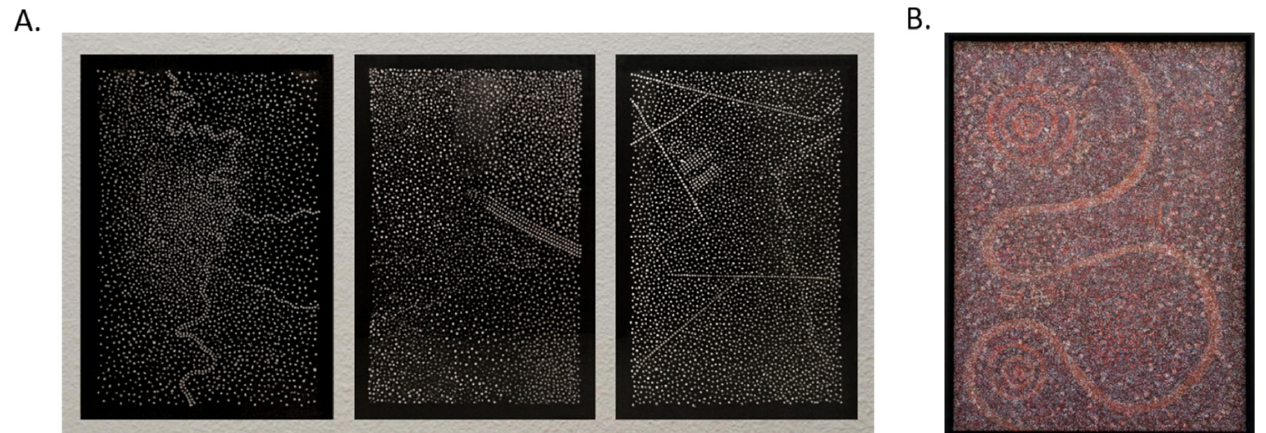
5 of 8 Figure 2. Pilot fungal dot painting on black acrylic glass. A total of 10 5 conidia/mL were suspended in molten YAG agar at 50–55 °C, point inoculated on black acrylic glass (50 × 70 cm) at 50 µL agar volume to generate the prominent dots or at 30 µL agar volume to generate the weaker background dots. The glass was incubated for 48 h at 37 °C in a humid box. A close-up photograph of the dots (right panel) reveals their heterogeneous mycelial density and texture. Finally, three fungal dot painting artworks were prepared on 80 × 120 cm black acrylic glass, using the methods developed above (Figure 3A). An example of an aborigi- nal art dot painting, which inspired our work, is shown alongside (Figure 3B). The paint- ing is by an aboriginal artist Barbara Weir and is entitled My Mother’s Country [20]. Abo- riginal paintings serve as a medium to convey one’s heritage and ancestral mythology, usually within the geographic context in which that heritage played out. The present se- ries of three paintings similarly relates to the artist’s heritage, depicting the cities and landscapes in which the artist’s family history unfolded. The use of mycelial culture in this context is essential and integral to the artistic concept. It ties in conceptually to the idea of a landscape or terrain being alive and serving as a cultural catalyst. More im- portantly, it makes a nuanced statement about cultural development by adding an arbi-